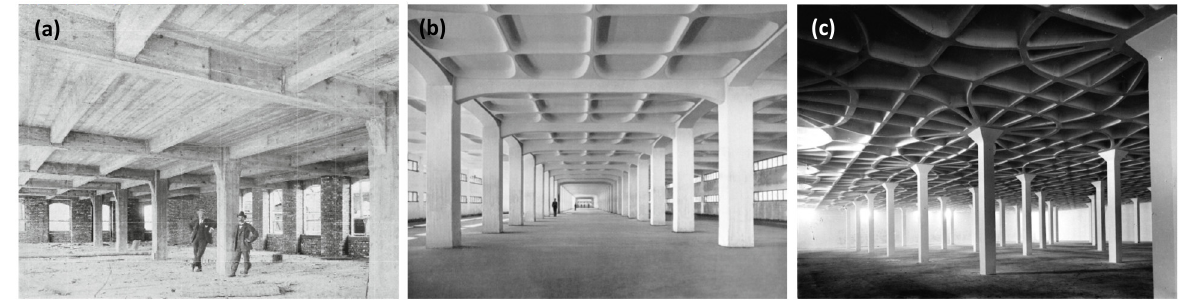
Figure 1. Compilation of historical ribbed floor slabs: (a) Möbelfabrik Reutlinger, Karlsruhe (1899, Photo: CNAM/SIAF), (b) Manifattura Tabacchi, Bologna (1949, [12]), (c) Lanificio Gatti, Roma (1953,